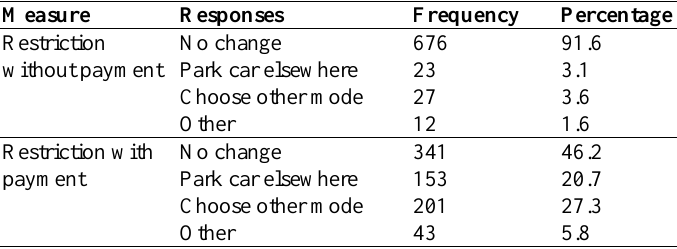
Table 2. Behavioral responses of car drivers to restricted access of the university